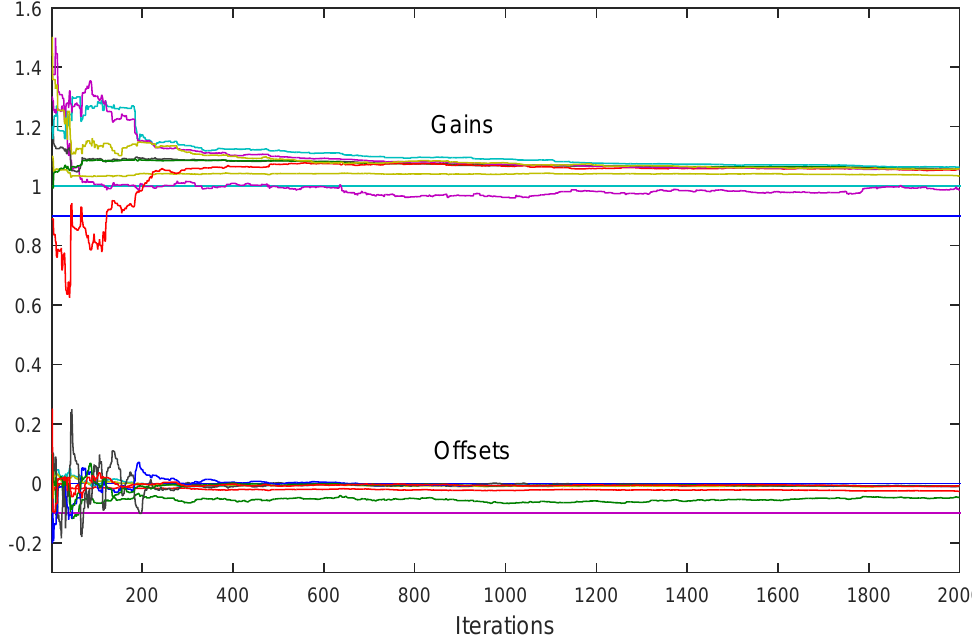
Figure 8. The asynchronous algorithm with two reference sensors with different characteristics: both the corrected gains and the corrected offsets converge to different values determined by